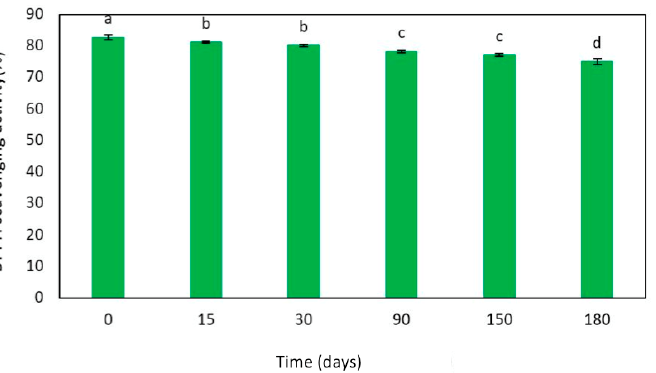
Figure 8. Effect of 6-month time storage of egagropili lignin fraction (0.15 mg) on 2,2-diphenyl-1- picrylhydrazyl (DPPH) scavenging activity during 90 min of sample incubation. Values with different small letters (a–d) were significantly different ( p < 0.05). Further experimental details are given in the text.